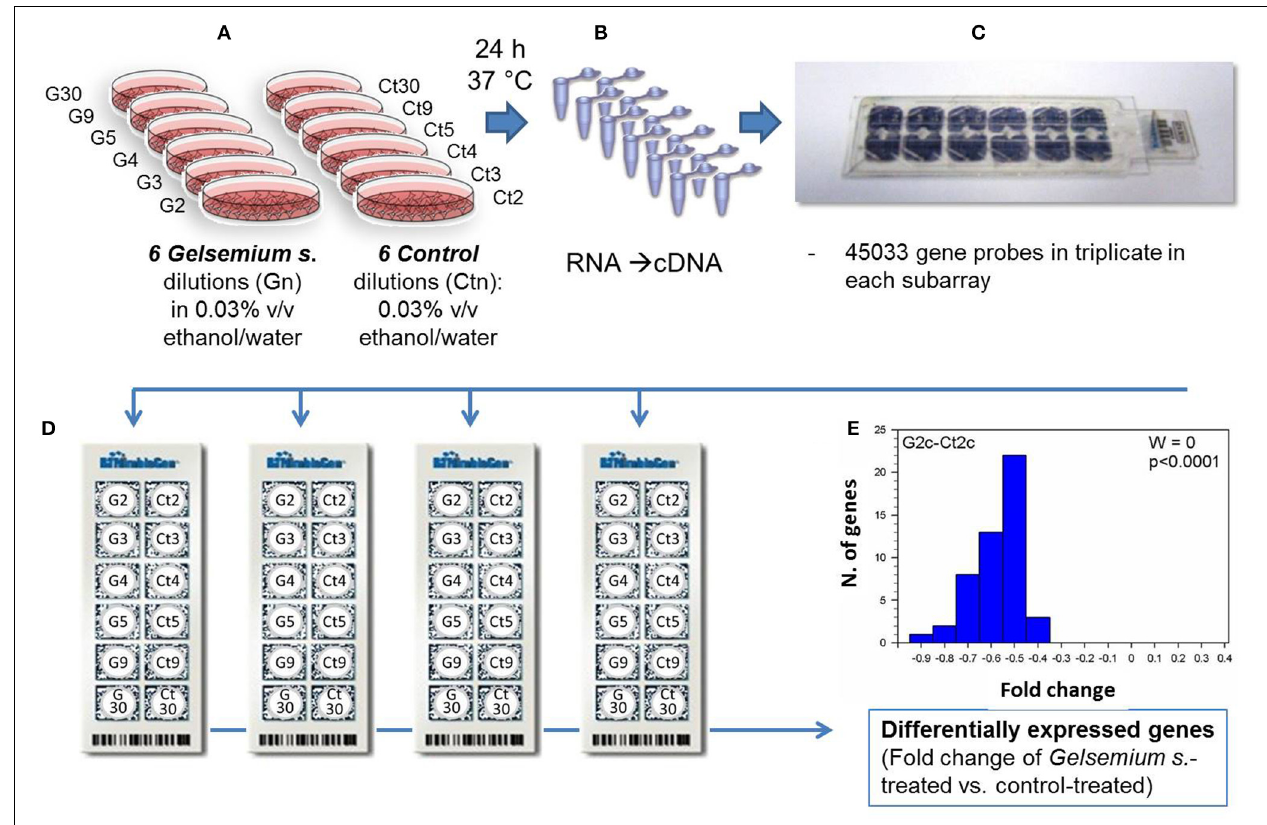
FIGURE 1 | Workflow of the main steps of the DNA-microarray experiments aimed to discover differentially expressed genes in Gelsemium-treated neuronal cells compared with control treated cells. Cultured SHSY5Y cells were incubated for 24h with the Gelsemium dilutions /dynamizations or the corresponding control, both treated with the same ethanol final concentration of 0.03% v/v (A) . After the treatment the RNA content was extracted from the cells, cDNA synthesized (B) and hybridized on Human Expression microarray (C) . In every subarray of the chip, each transcript was targeted with three separate probes, merging the fluorescence values and attributing a statistical score. Four independent